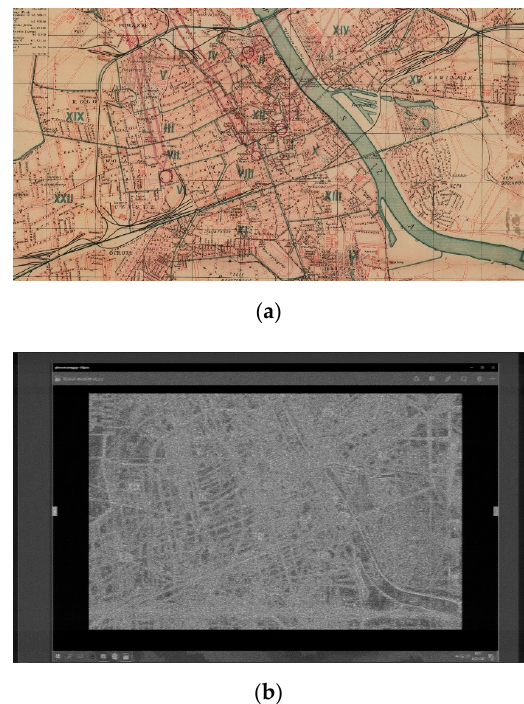
Figure 15. Example images. ( a ) The original image of the Warsaw city plan from 1934 (public domain, resolution 1920 × 1080), and ( b ) a restored image of the Warsaw city plan displayed on a computer monitor ( f o = 1155 MHz, BW = 50 MHz, sampling frequency f s = 125 MHz) using DVI standard.